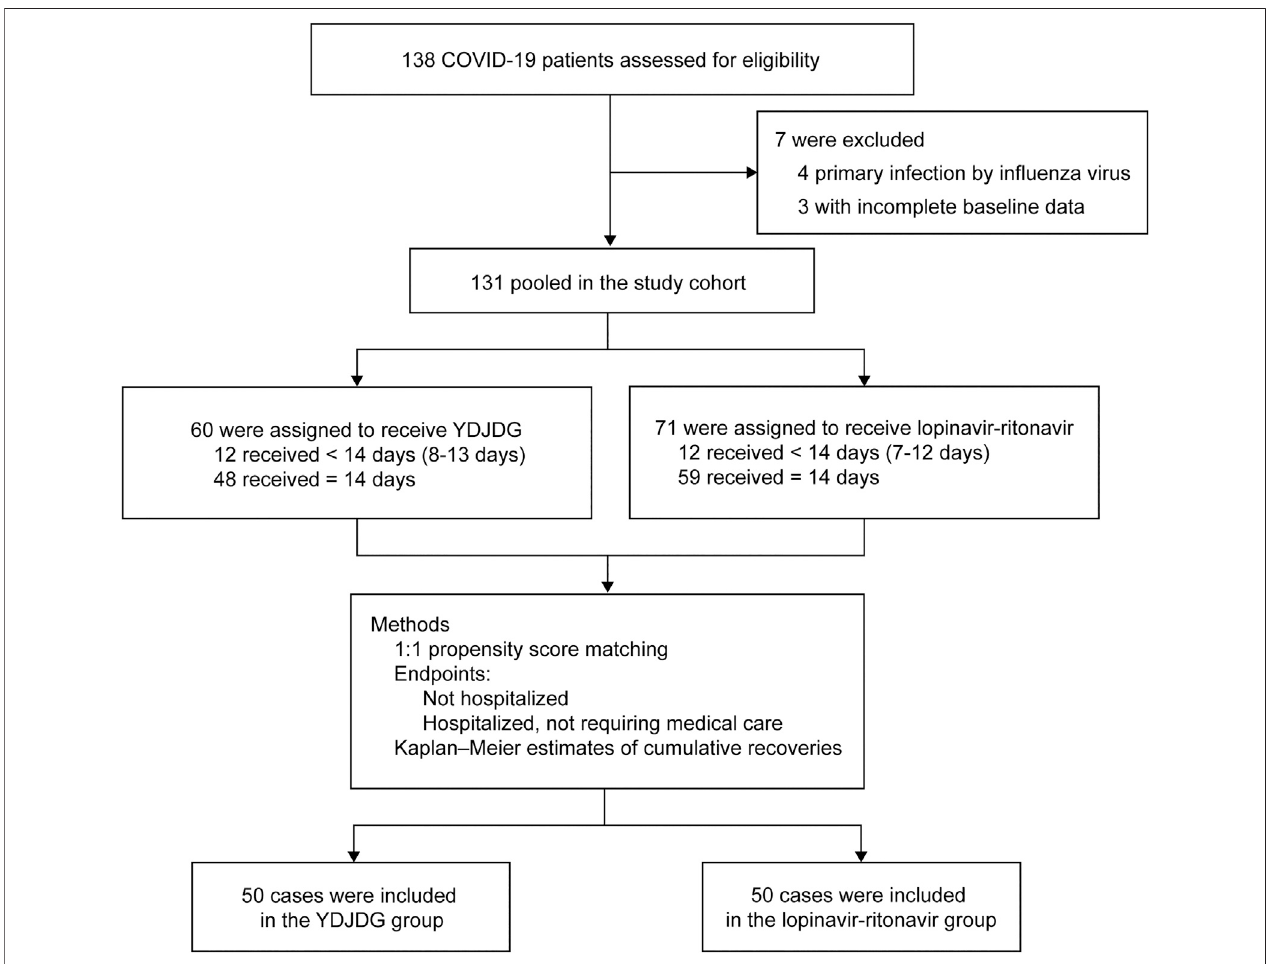
FIGURE 1 | Study fl ow chart. YDJDG, Yindan Jiedu granules; COVID-19, Coronavirus disease-2019.